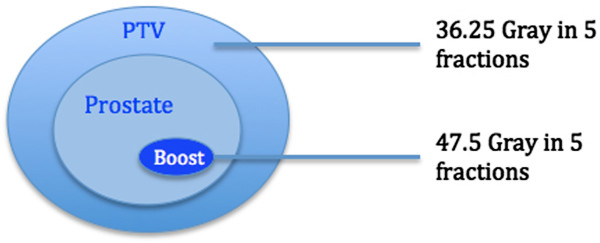
Planning schema.